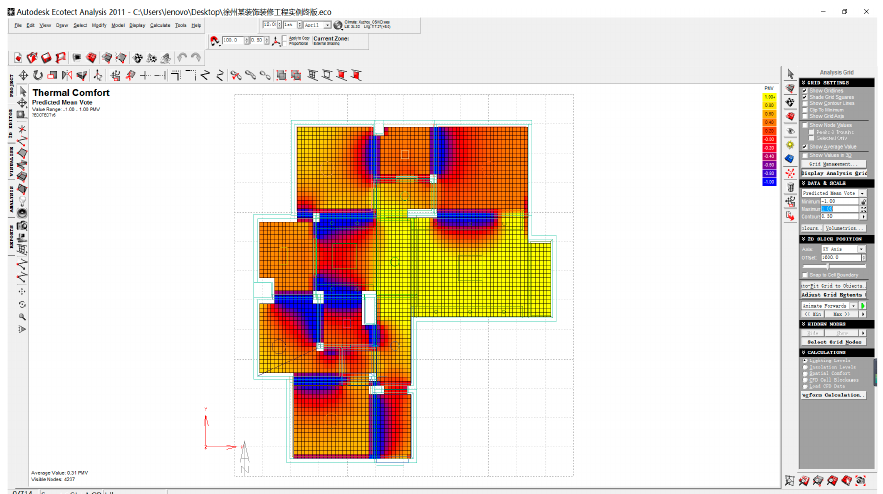
Figure 7. Thermal comfort PMV analysis results of indoor areas of a decoration project.